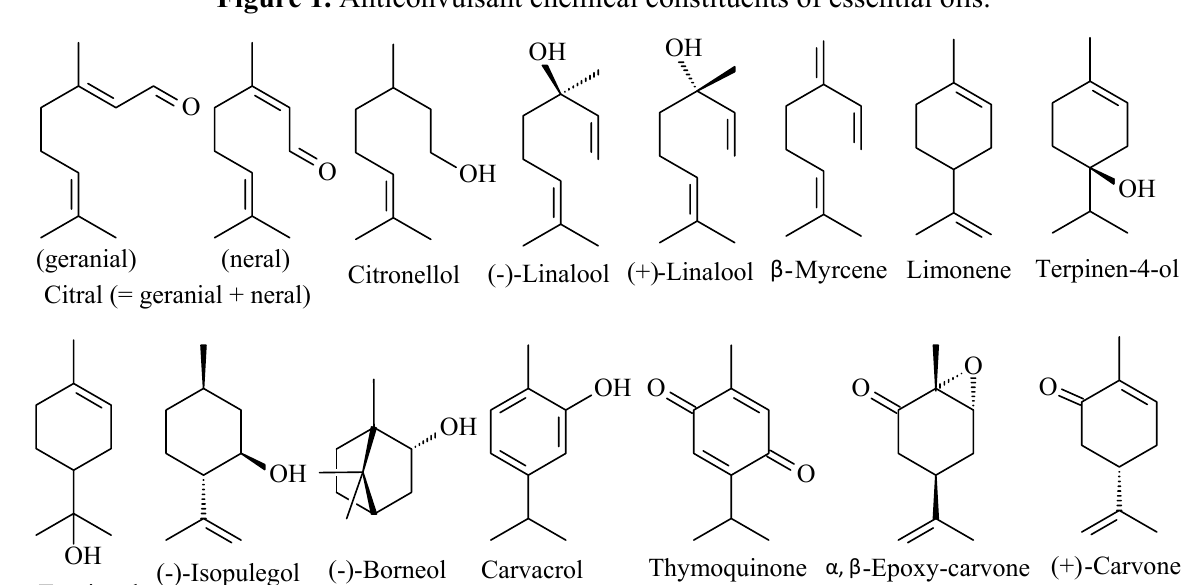
Figure 1. Anticonvulsant chemical constituents of essential